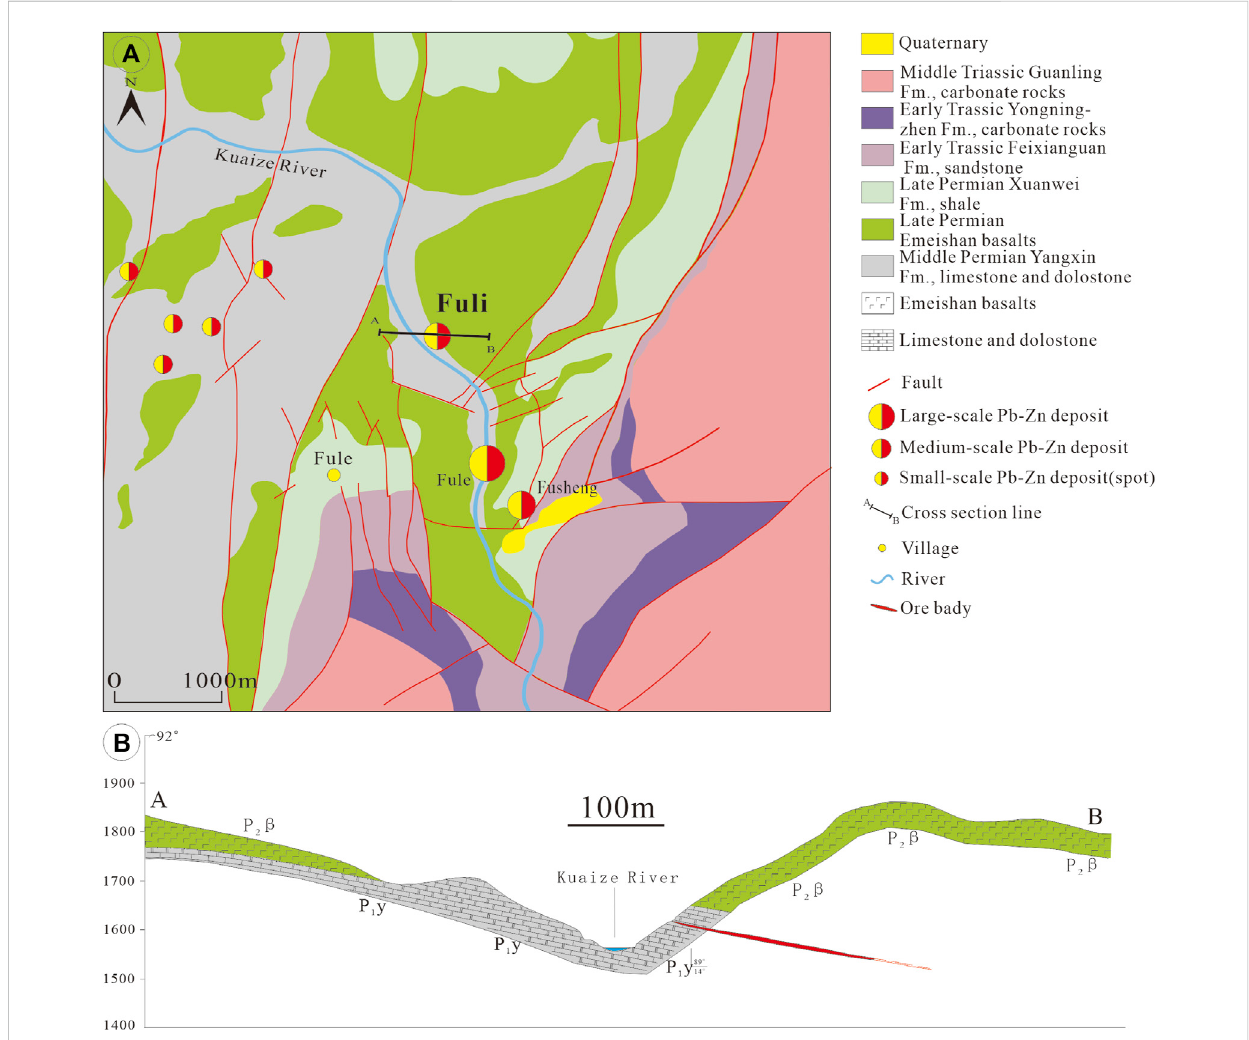
FIGURE 2 (A) GeologicalmapoftheFuliPb − ZndepositshowingthestructureandtheA-Bcross-section. (B) A-BCross-sectionoftheFulidepositthroughthe Fuli deposit showing the ore body, structure and